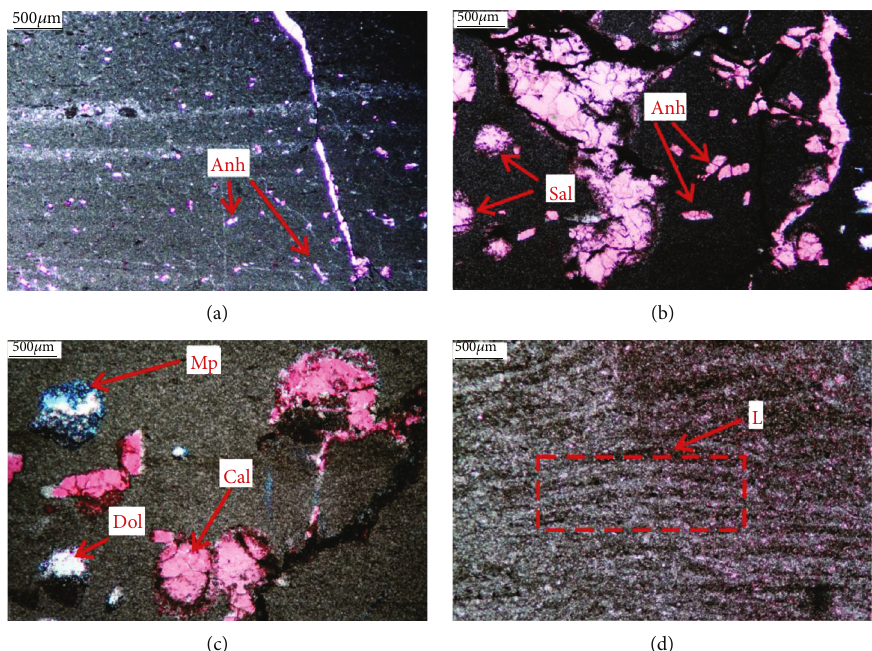
Figure 3: Microphotographs showing the petrographic characteristics of the Type-1 dolostone in Submember Ma5 Ordos Basin (Anh=anhydrite, Mp =moldic pore, L =laminae, Dol=dolomite, Cal =calcite, and Sal =salt). (a). micritic dolostone, 3107.4m, well Y1758; (b). salt and anhydrite developed in micritic dolostone, 3859.5m, well Y1112; (c). moldic pore developed in micritic dolostone, 3860.0m, well Y1112; (d). laminated structure of stromatolite dolostone, 4089.6m, well Y1165).